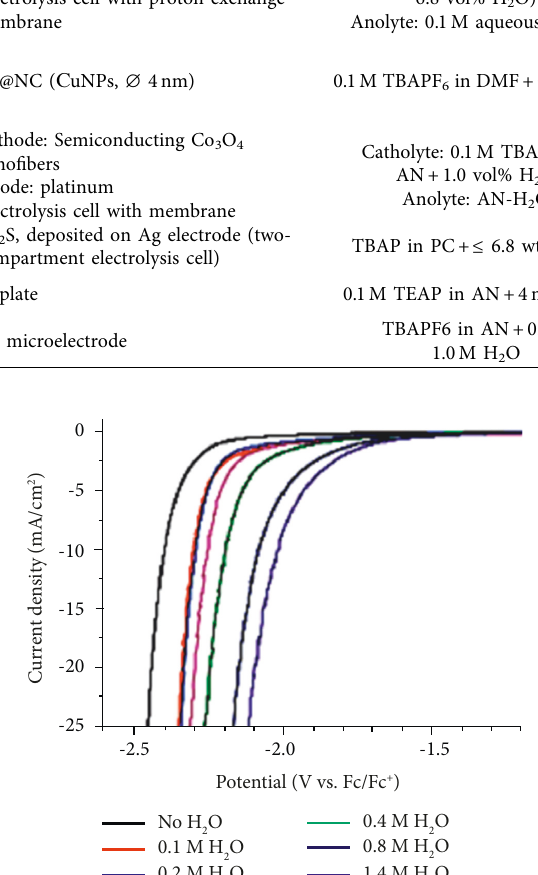
Figure 7: Influence of water concentration on polarization curves MoO 2 /Pb in CO 2 -saturated MeCN at − 20 ° C. Electrolyte: 0.1M TBAPF 6 ; scan rate: 50mV · s 1 from [54] under the terms of the Creative Commons CC BY